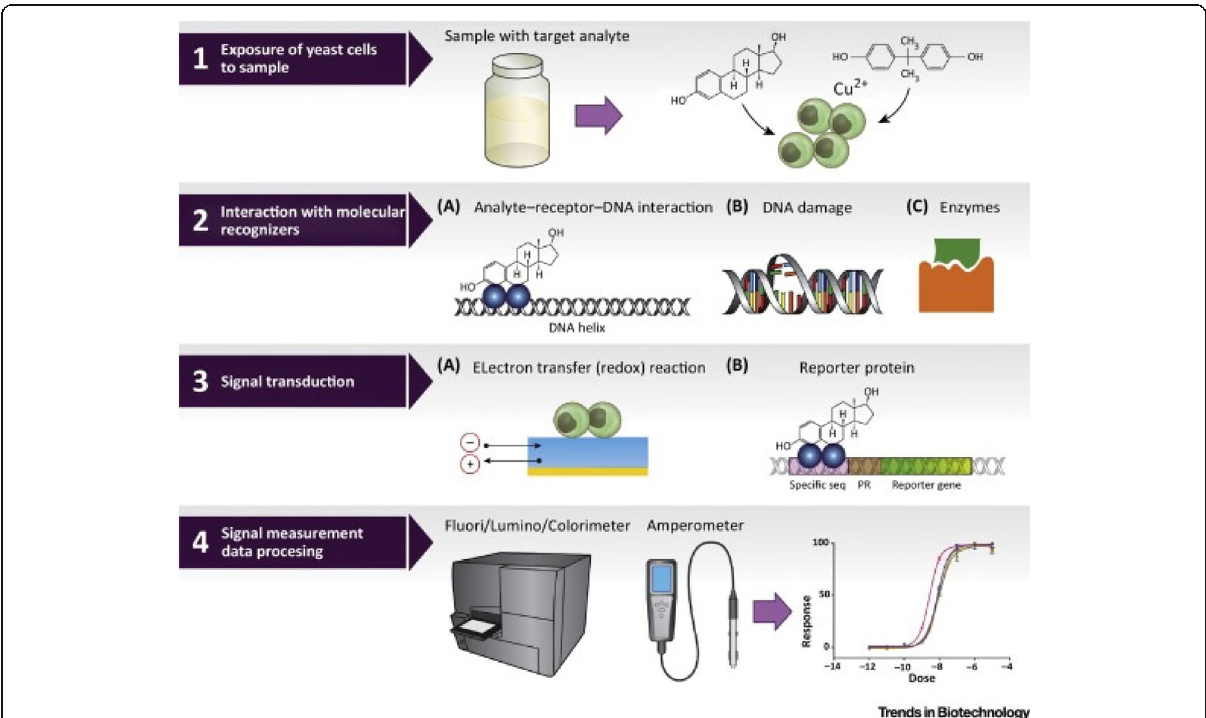
Fig. 10 Examples of immobilization strategies for yeast biosensors. (Reprinted with permission from Reference Jarque et al. 2016). © 2016 Elsevier